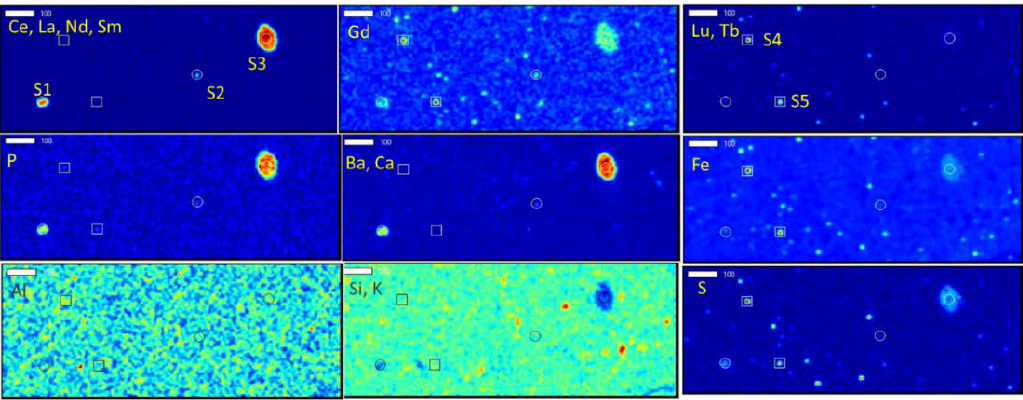
Figure 8. Synchrotron µXRF maps of selected REEs and major elements in UC-02 at BL 2-3 3 with 5 µm step size, 50 ms dwell time at excitation energy at 9500 eV. The scale bar is 100 µm. Spots in empty circles are Ce hotspots 78_As1 as Ce(+3) in Ca-rich aluminosilicates and 78_As2 as Ce(+4) oxide, independent of glass phase, with µXANES collected. The color scale on each map from blue to yellow to red represents XRF signal intensity from low to high, as displayed in all other µXRF maps. Light REE spots (e.g., Ce, La, Nd and Sm) in empty circle are co-localizing with Ca, P and Ba, whereas heavy REE spots (e.g., Gd, Lu and Tb) in empty square are co-localizing with Fe and S.